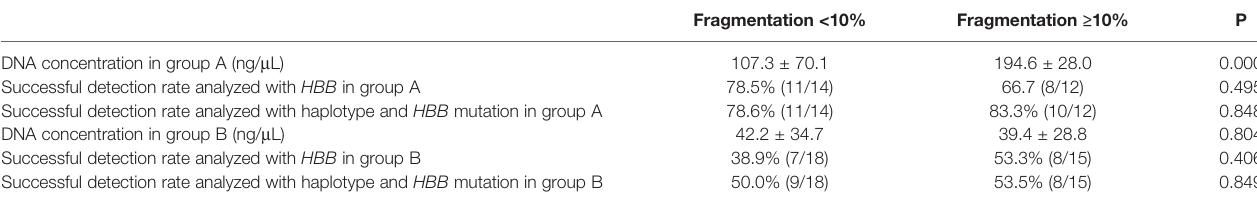
TABLE 2 | Analysis of fragmentation and DNA concentration and successful detection